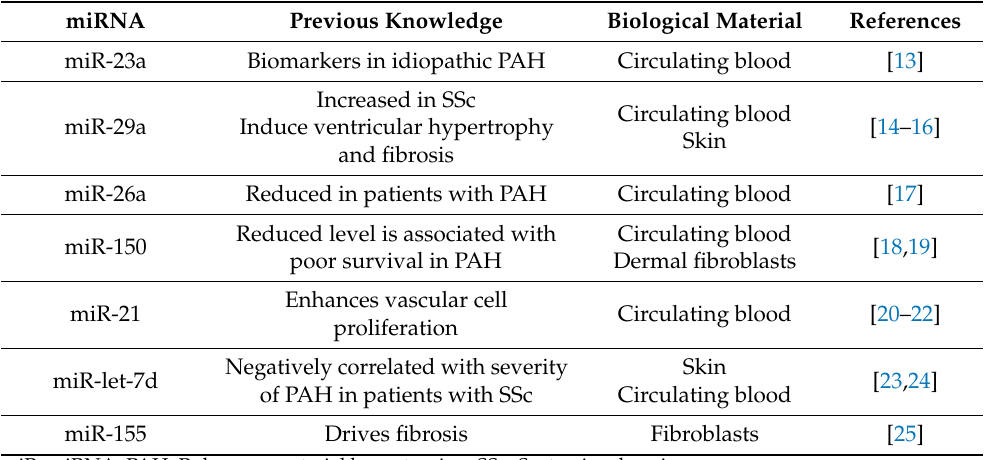
Table 2. miRNAs that characterize pulmonary fibrosis, PAH or are involved in the development of